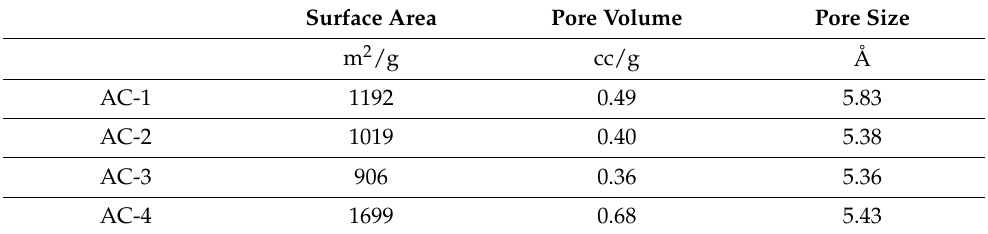
Table 1. Surface area, pore volume, and pore size of activated carbon sample.